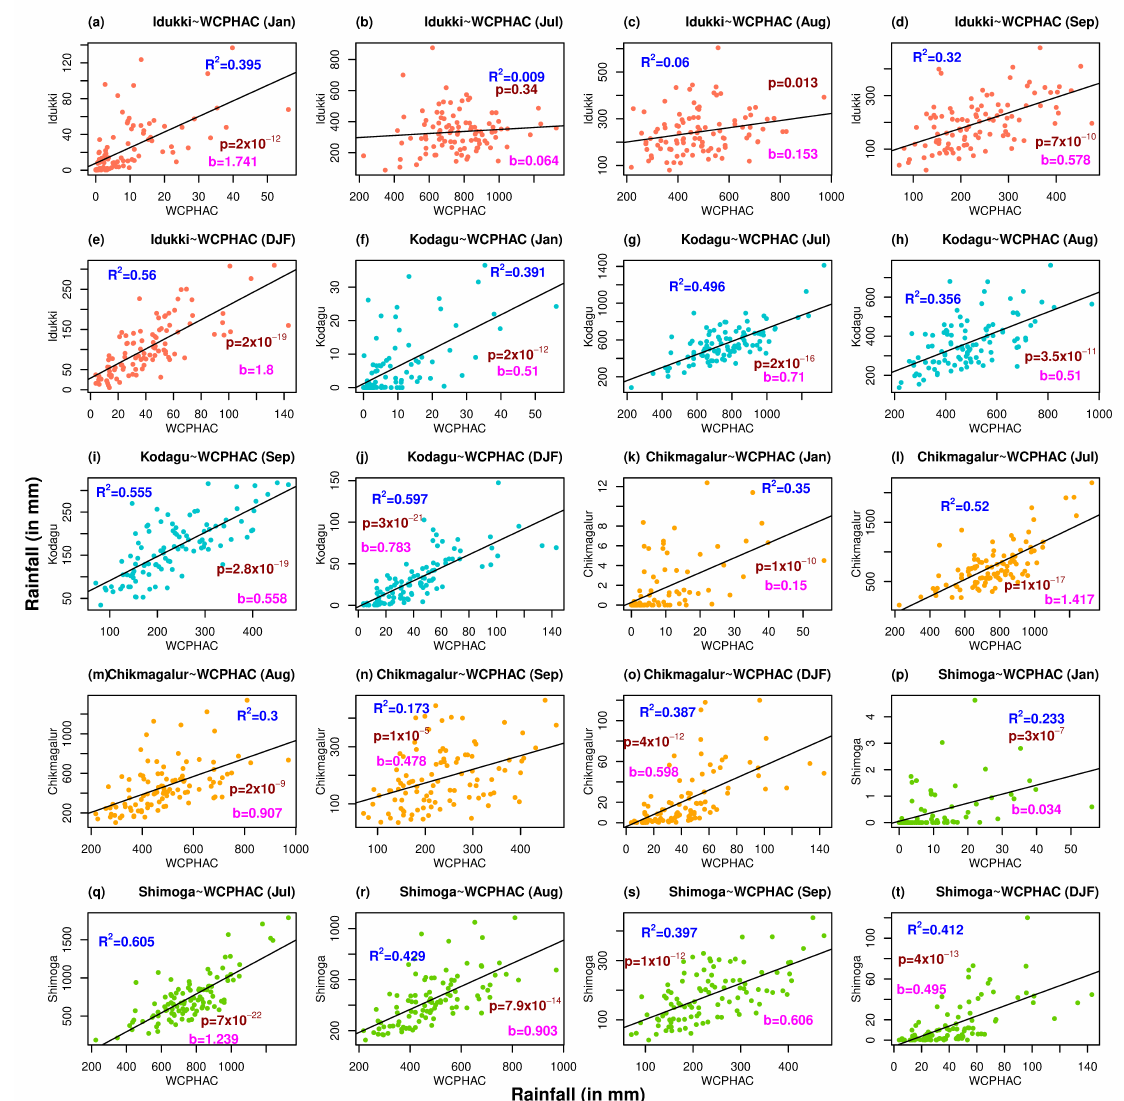
Figure 2. Linear tendency of district rainfall with WCPHAC region from 1902–2002. The trend in all the cases is significant at a 99% level except Figure 2b (significant at a 66%